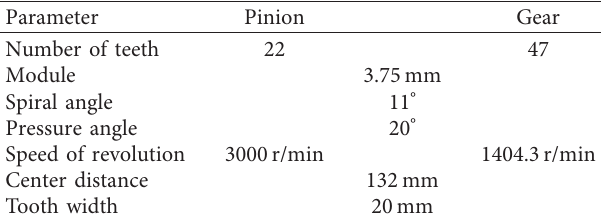
� t ) 1 Table 1: Geometry parameters of the helical gear pair.